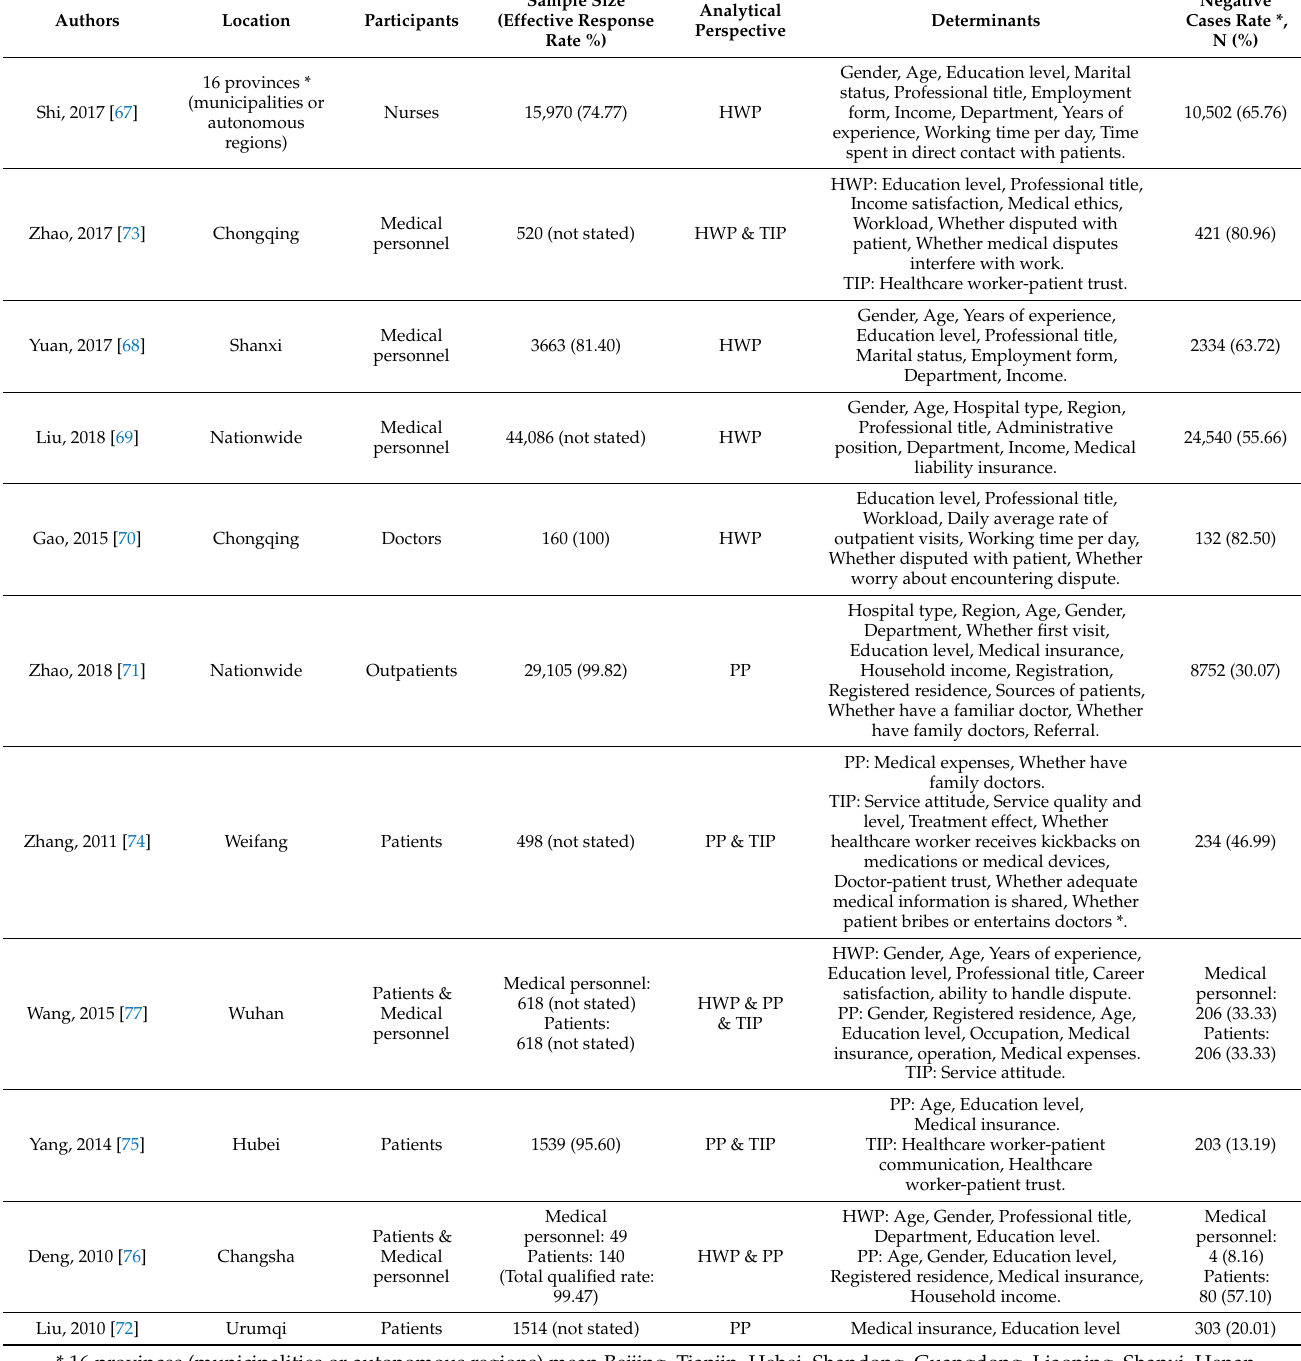
Table 2. Characteristics of 11 included